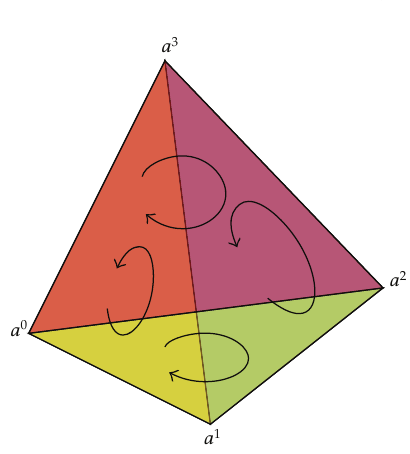
Figure 2: A simplicial complex with orientation in R 3